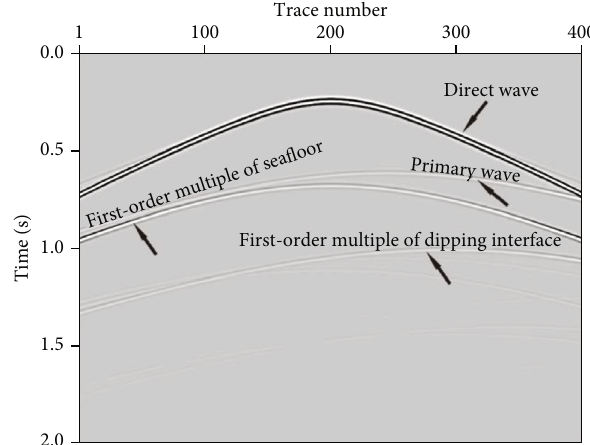
Figure 6: The wave fi elds generated by two-way wave equation wave fi eld simulation